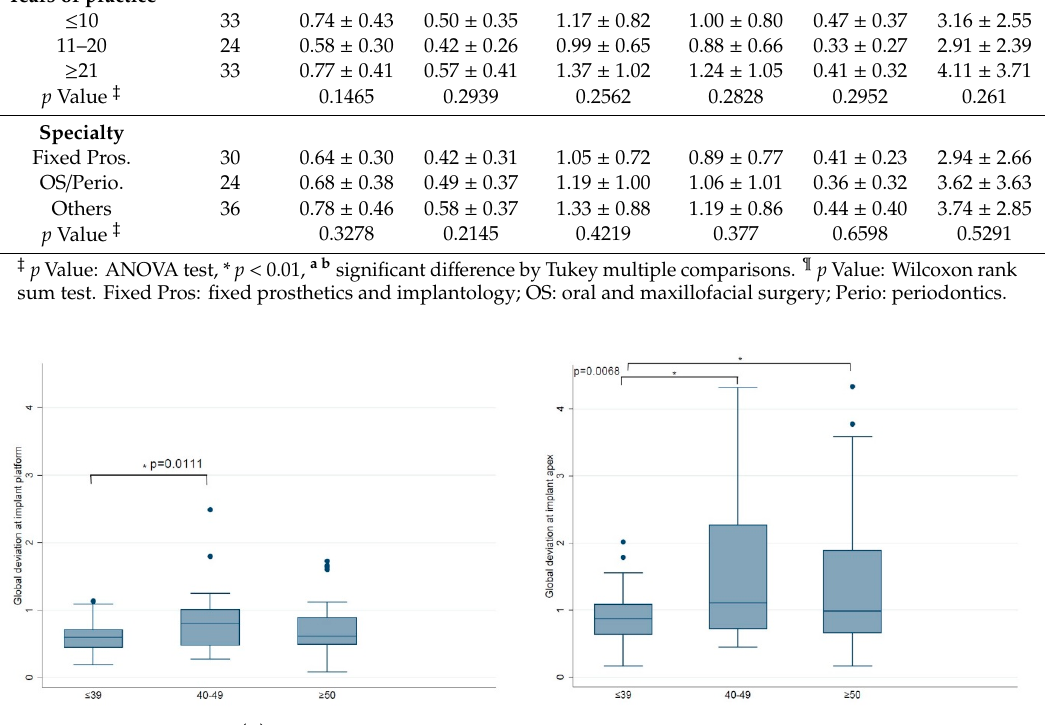
( b ) Figure 11. Box plots of the lateral deviation at the implant: ( a ) platform and ( b ) apex of the three operator age groups. ( a ) ( b ) Figure 12. Box plots of the ( a ) depth deviation and ( b ) angular deviation of the three operator age groups. 4. Discussion To the best of our knowledge, this was the first study to use the optical-scan-based measurement method to investigate the influence of operator experience on the accuracy of static guided implant surgery. The results of this study revealed that for mandibular partial edentulism of